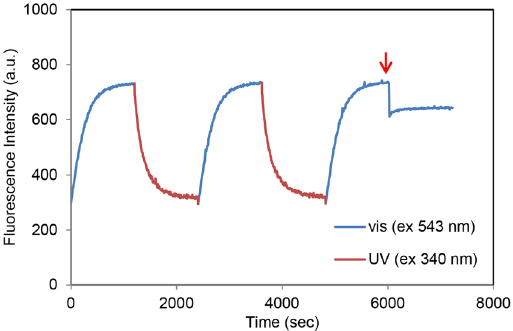
Figure 6. Photoswitchable Förster resonance energy transfer (FRET) between N -NBD-DOPE and N - nitroBIPS-DPPG. Time course of NBD fluorescence emission of DOPC/ N -NBD-DOPE/ N -nitroBIPS- DPPG (89:1:10) liposomes. Representative data of three independent experiments. Blue line, sample was concomitantly irradiated with blue green (480 nm) and green (543 nm) light, deactivating NBD quenching; red line, sample was concomitantly irradiated with blue green (480 nm) and UV (340 nm) light, activating NBD fluorescence quenching; red arrow, indicates addition of Triton